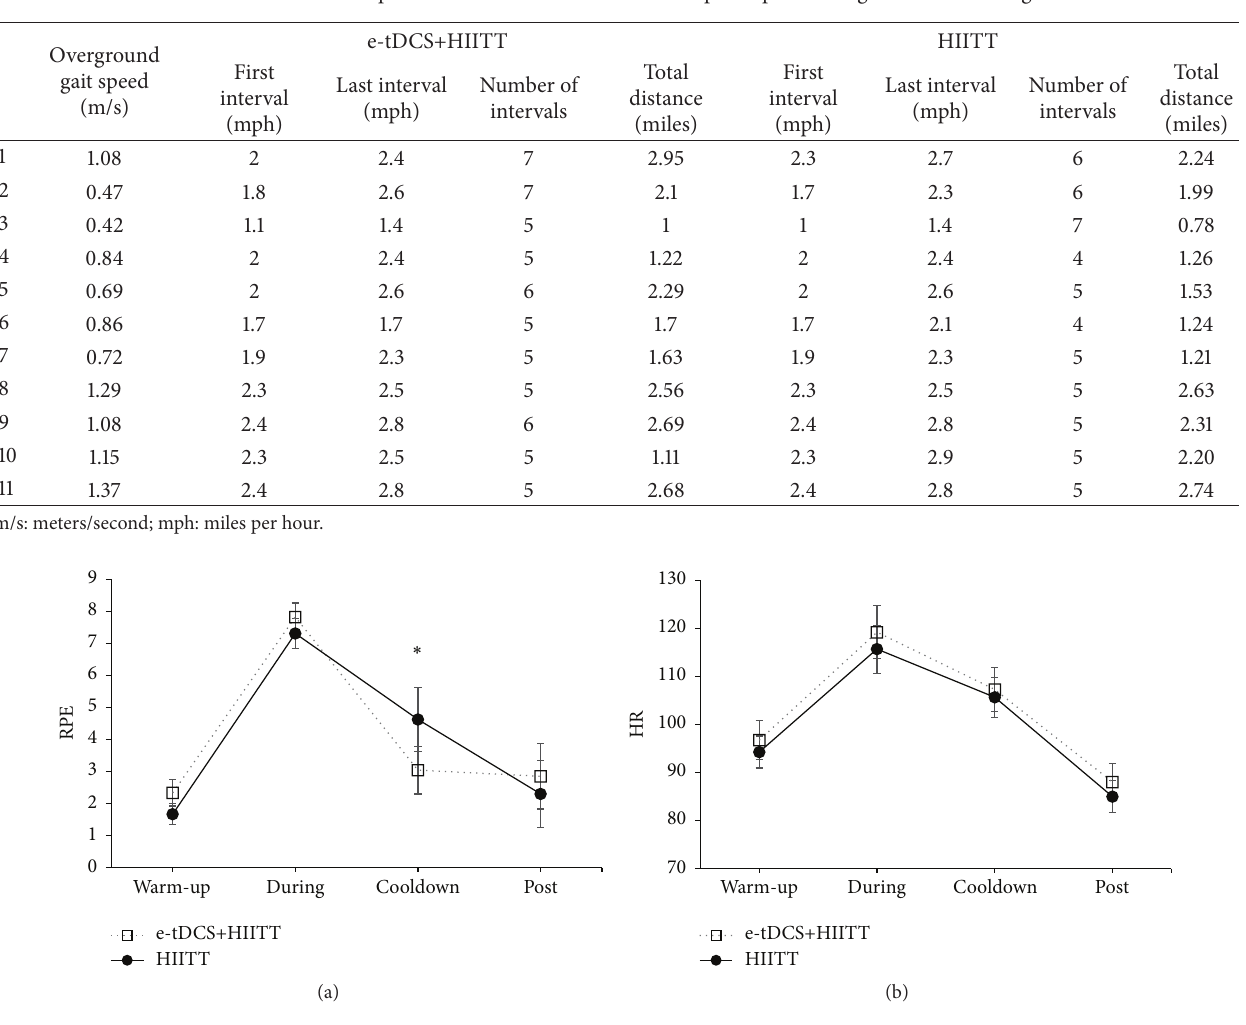
Figure 2: Rating of perceived exertion (RPE) and heart rate (HR; beats per minute (bpm)) are shown in Figures 2(a) and 2(b), respectively. 𝑦 -axis represents 4 different time points at which these measurements were taken. Data are means and error bars are standard errors. There was a significant difference between the two sessions during cooldown for the RPE. A significant effect of time was noted for HR. ∗ 𝑝 < 0.05 .